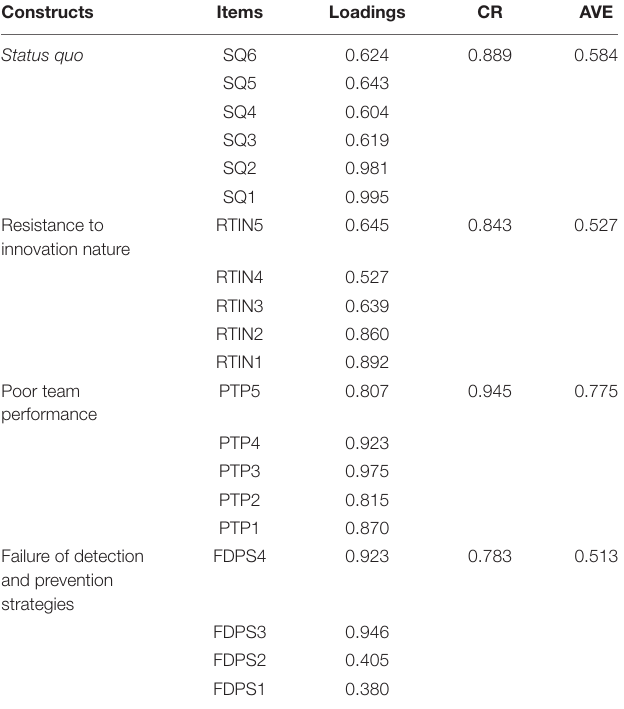
TABLE 1 | Convergent validity.